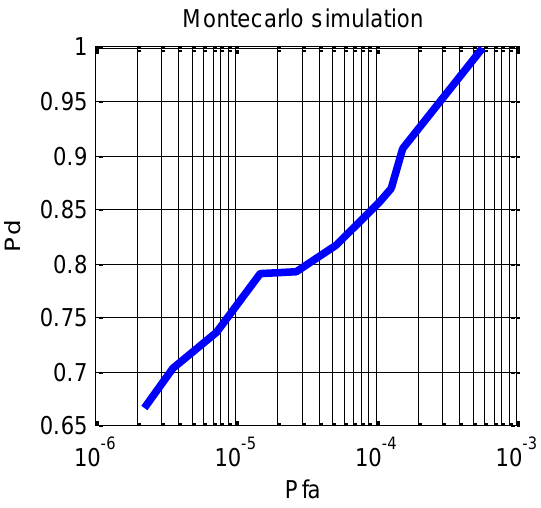
Figure 6. Detection performance of a single sensor. Monte Carlo